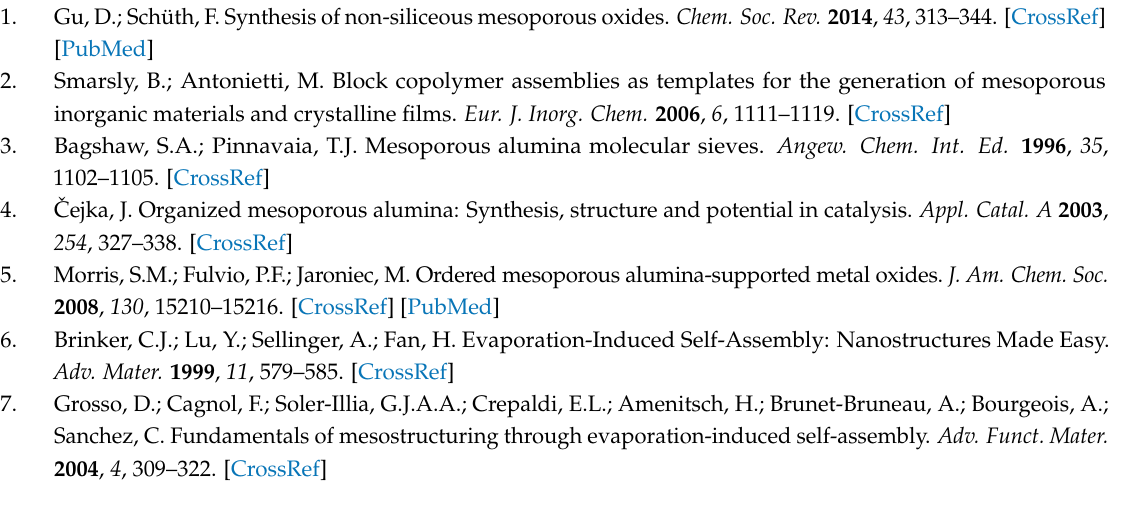
Figure S4: SEM images of Al 2 O 3 and MgO layers prepared by pre-mixing, Table S1: EDX analysis, Table S2: EDX analysis, Table S2: Amounts of polymer and metal salts for pre-mixing Amounts of polymer and metal salts for pre-mixing synthesis.